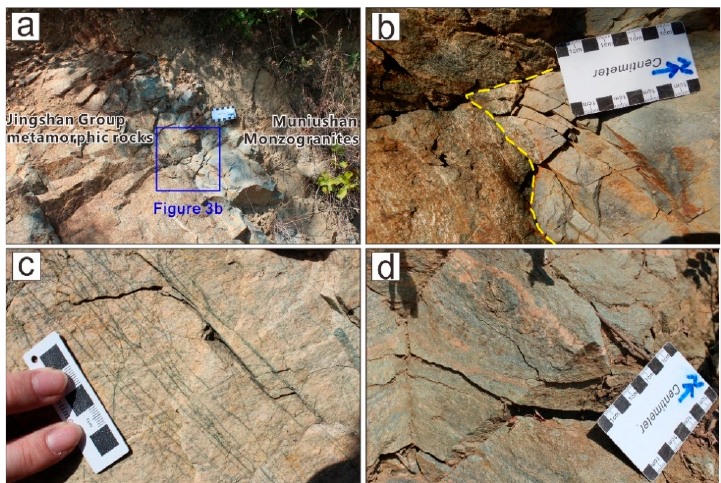
Figure 3. Field photographs of the Muniushan monzogranites. Field photographs showing the Monzogranite intrudes into the Paleoproterozoic Jingshan group ( a,b ). Field photographs showing the shear joint and mylonitization on the monzogranite ( c,d ).